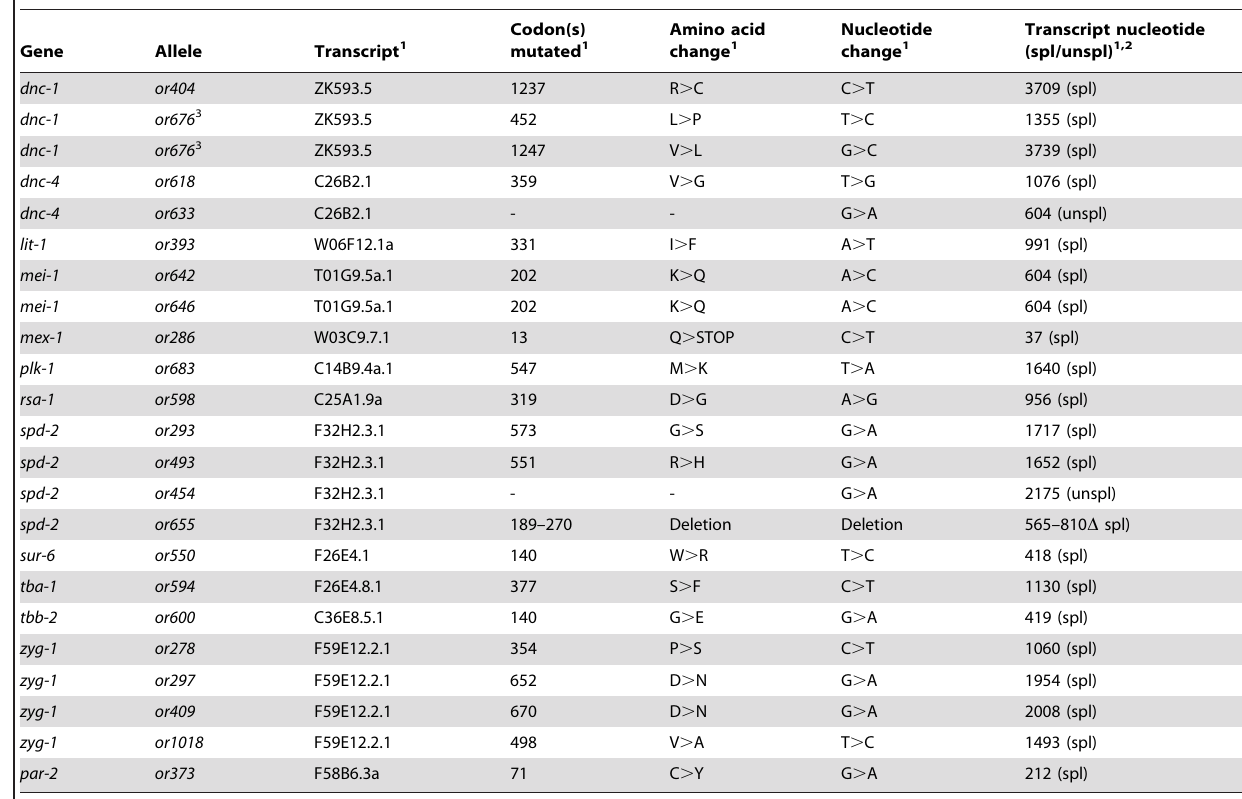
Table 2. Sequence alterations in the TS